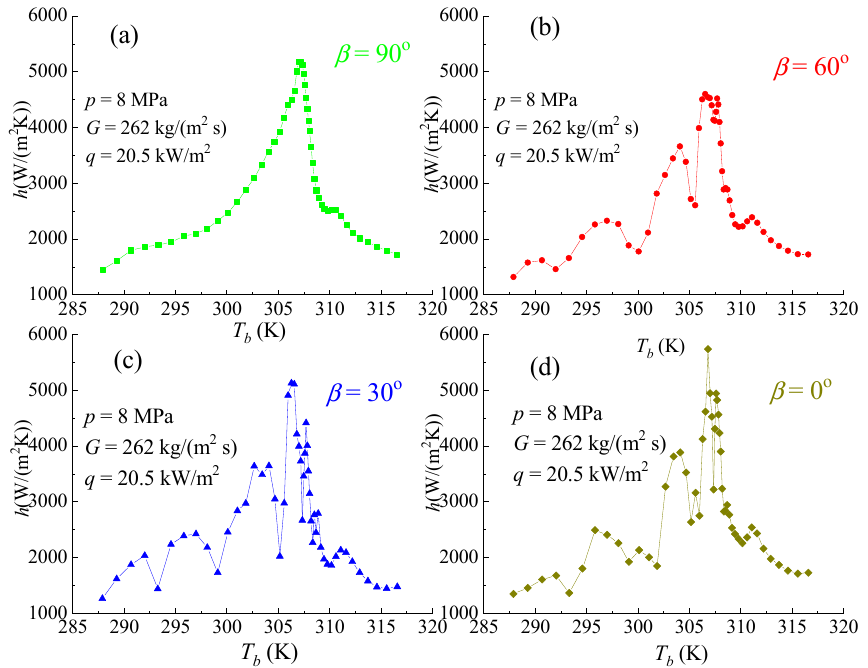
Figure 6. The heat transfer coefficient of supercritical CO 2 flowing in helically coiled tube at various dip angles [19]: ( a ) vertical without oscillation ( β = 90°); ( b ) incline with small oscillation ( β = 60°); ( c ) incline with mild oscillation ( β = 30°); ( d ) horizontal with severe oscillation ( β = 0°).